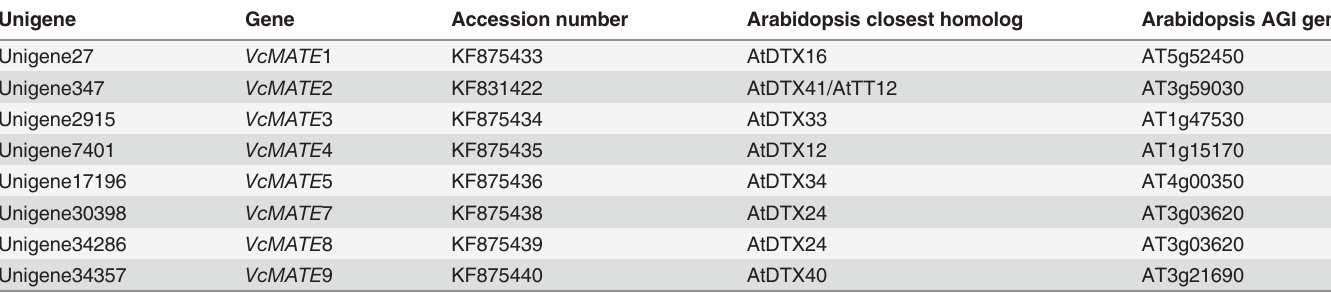
As presented in Table 3, Vc MATE cDNA encoded proteins are composed of 477 – 537 residues, with predicted molecular masses around 54 kDa, theoretical isoelectric points from 4.89 to 8.41, aliphatic indices between 113.88 and 126.29, and grand average of hydropathicity around 0.7. All deduced Vc MATE proteins were predicted as stable because their instability index is smaller than 40. When analyzed by SOPMA, the secondary structures of blueberry MATEs were predicted to be mainly composed of alpha helices (60.34 – 68.13%) interspersed with ran- (Fig. 1). For each protein, there were more than 15 distinct alpha helices dispersed along the length of the protein. The prediction of transmembrane domains using HMMTOP suggested that there were 10 – 12 putative transmembrane (TM) segments in Vc MATEs (Fig. 2). Table 2. Putative MATE transporters from blueberry and their closest Arabidopsis homologs. Unigene